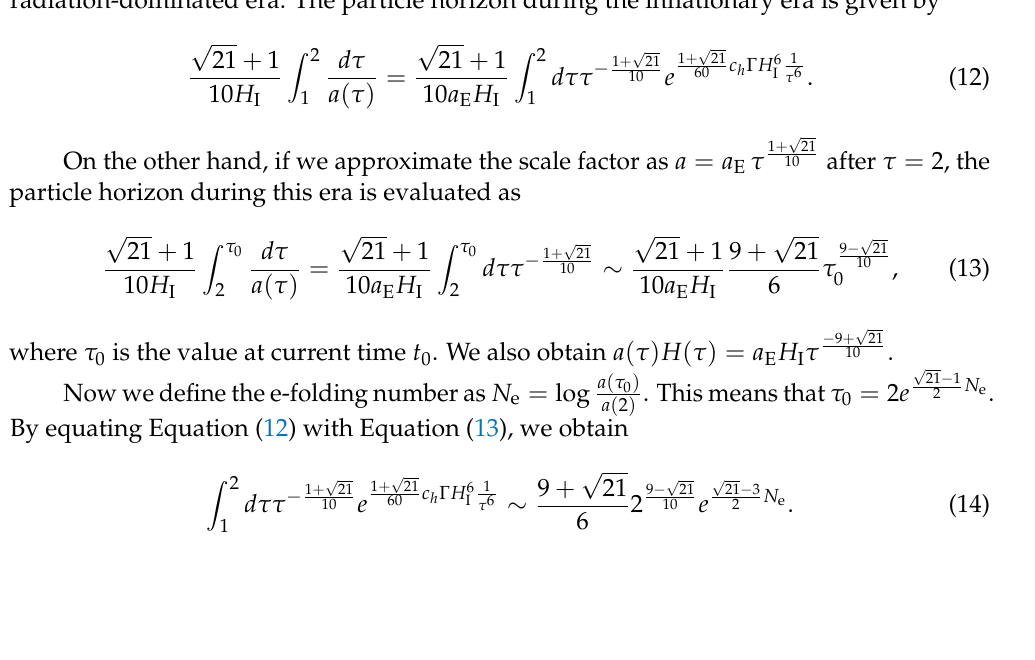
√ 21 log τ (blue), 1 + 10 = 0.014 and c (cid:48) I